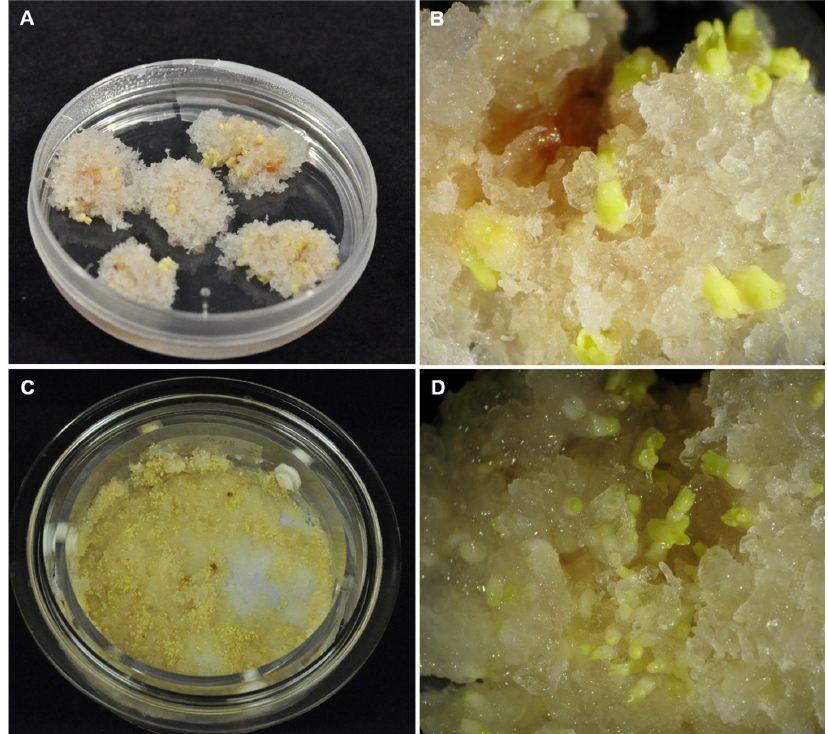
Figure 4. Somatic embryogenesis of A. nordmanniana on solid culture medium (top row) and in the TIB (bottom row). ( A , D ) Maturation of A. nordmanniana somatic embryos using solid and liquid Brown and Lawrence (BLG) medium supplemented with 45 g ∙ L − 1 maltose, 50 g ∙ L − 1 polyethylene glycol (PEG-4000) and 40.1 µ M abscisic acid (ABA), respectively. ( B , D ) Fully mature cotyledonary embryos after eight weeks on solid culture medium and in the TIB,